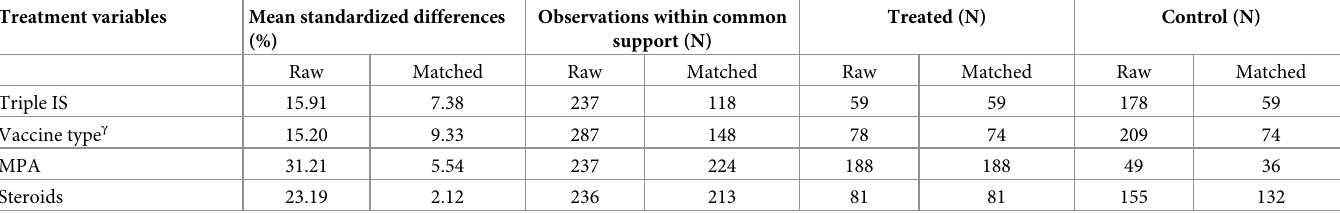
Table 1. Summary of propensity matching. Treatment